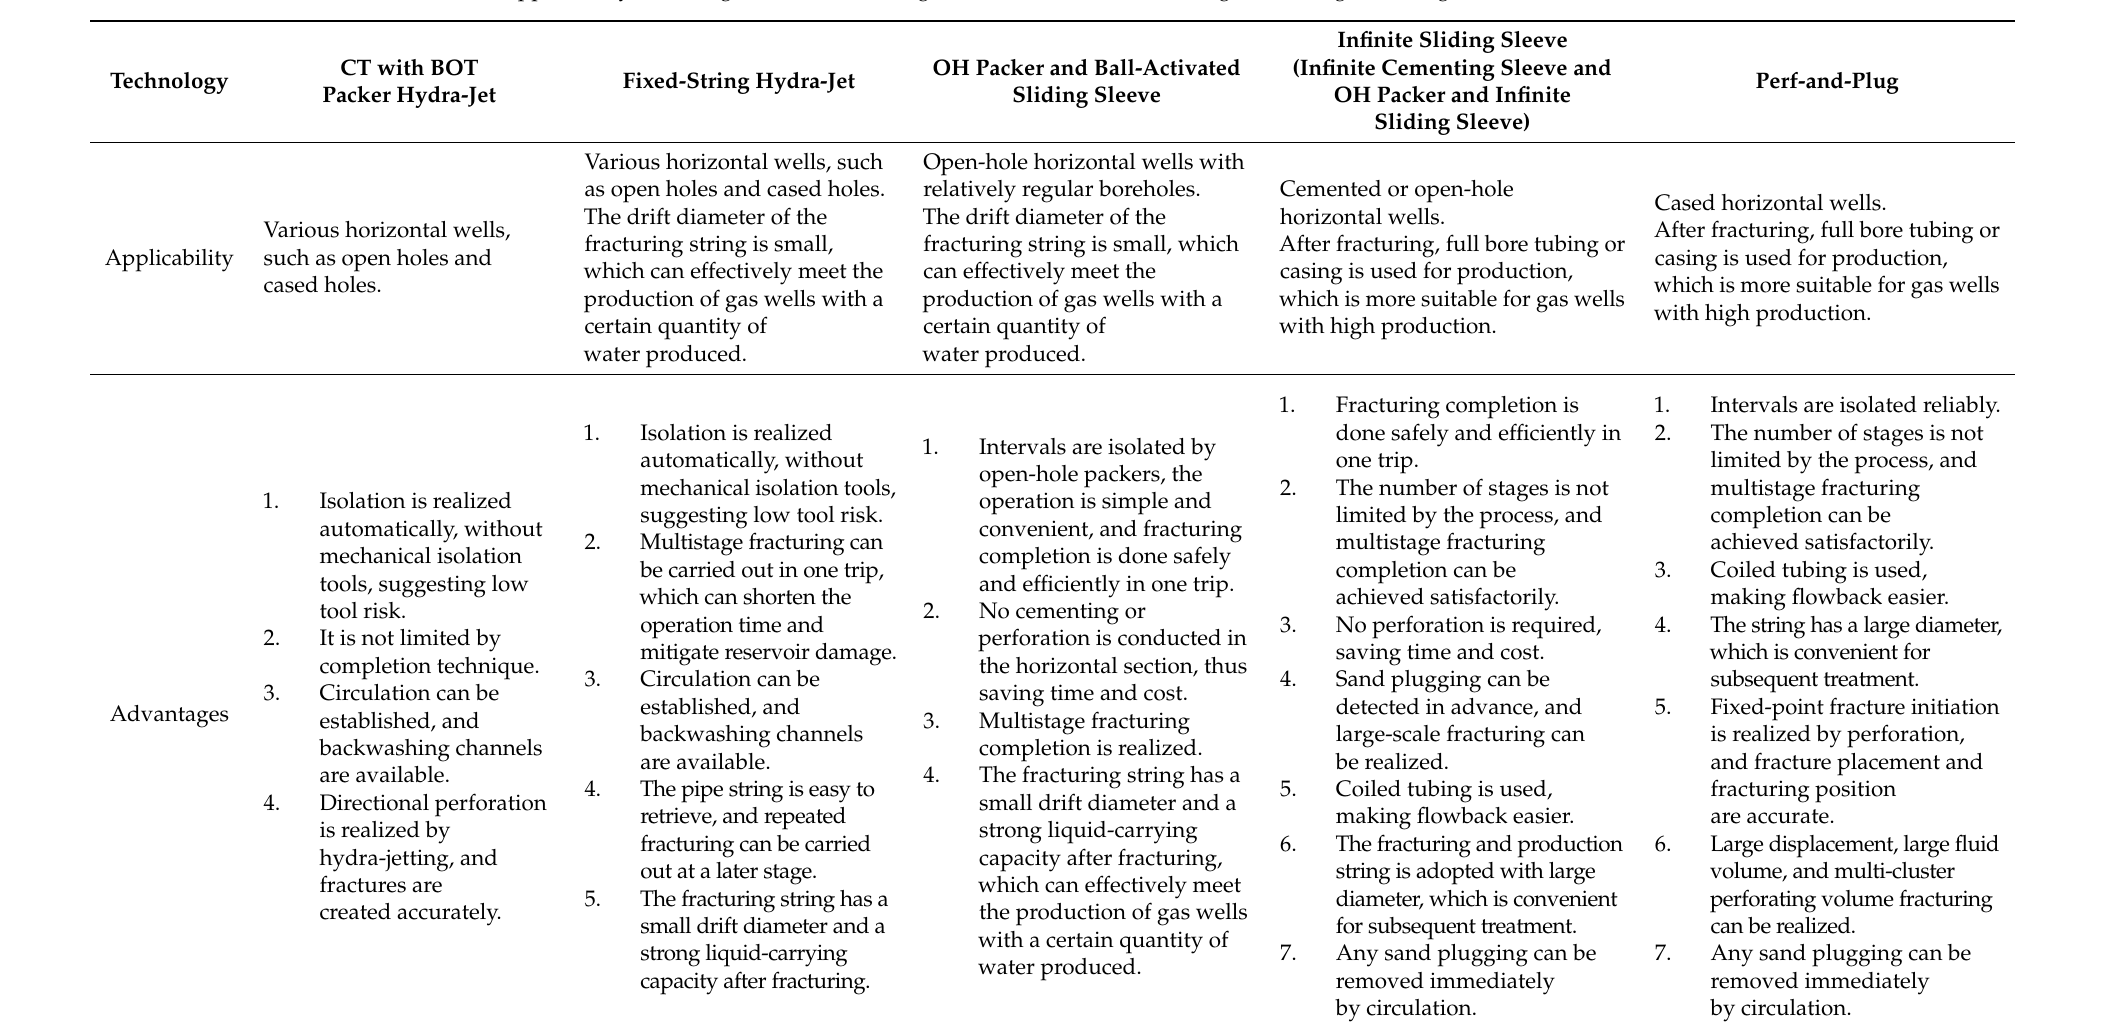
Table 1. Applicability, advantages, and disadvantages of horizontal well multistage fracturing